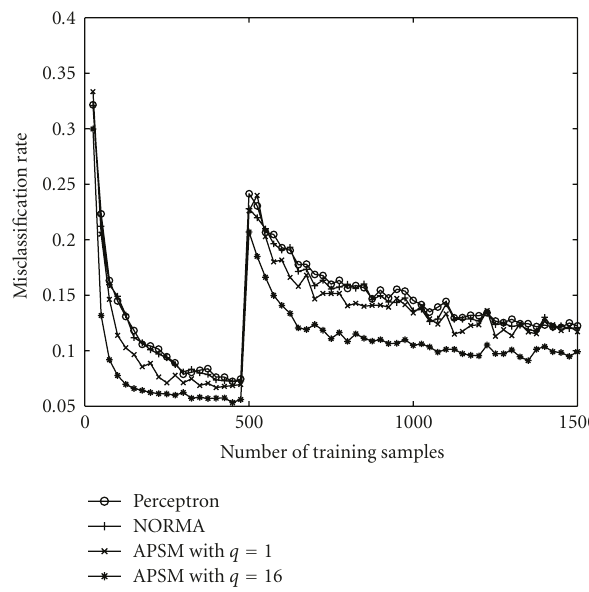
Figure 7: A channel switch occurs at time n = 500, from H 1 to H 2 , for the LTI system in Figure 3. No sparsification for the APSMs, and no regularization for NORMA is considered here. The variance of the Gaussian kernel function is kept to the value of σ 2 : = 0 .